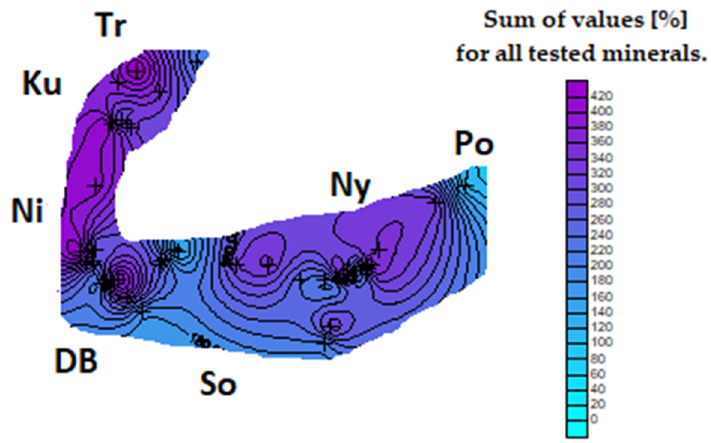
Minerals 2021 , 11 , x FOR PEER REVIEW Figure 6. Map showing the % sum of the fractal ratio for olivine, orthopyroxene, clinopyroxene, and plagioclase in Monchepluton. Abbreviations: Tr—Traviannaya; Ku—Kumuzhia; Ni—Nittis; DB—Dunite Block; So—Sopcha; Ny—Nyud; Po—Poaz.